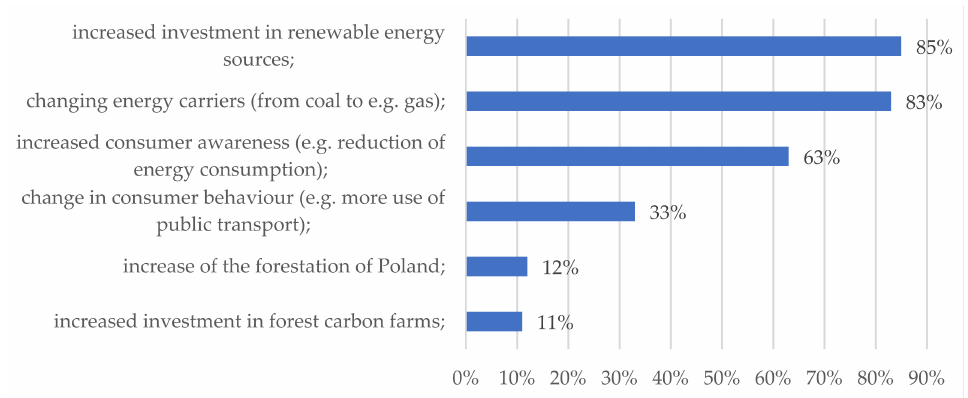
Figure 13. Statistics of responses to the question: What effects can decarbonization policies